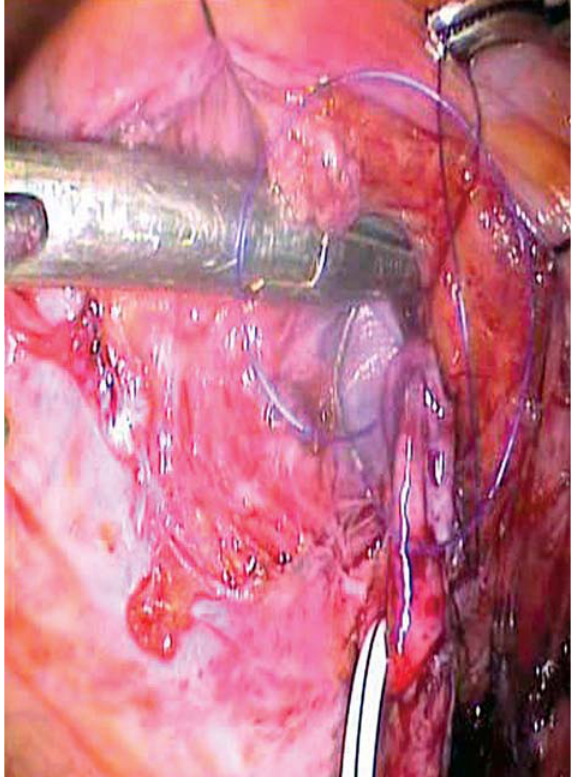
Figure 4 – Operative view of a right laparoscopic uretero-vesi- cal